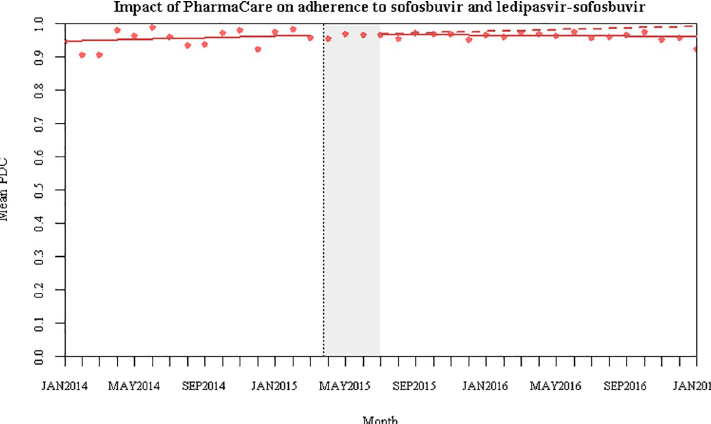
Fig 2. Interrupted time series model for the impact of PharmaCare on adherence to sofosbuvir and ledipasvir- sofosbuvir. The last data point (January 2017) only covered a partial month as the last treatment initiation was January 14, 2017. Thus, there may be small adjustments to the model had we included data for that entire month. PDC: proportion of days covered.